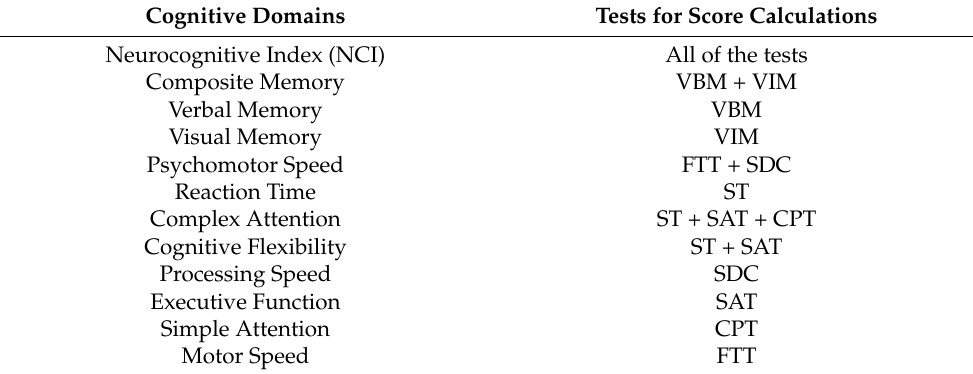
Table 1. Cognitive domain scores in CNS Vital Signs.